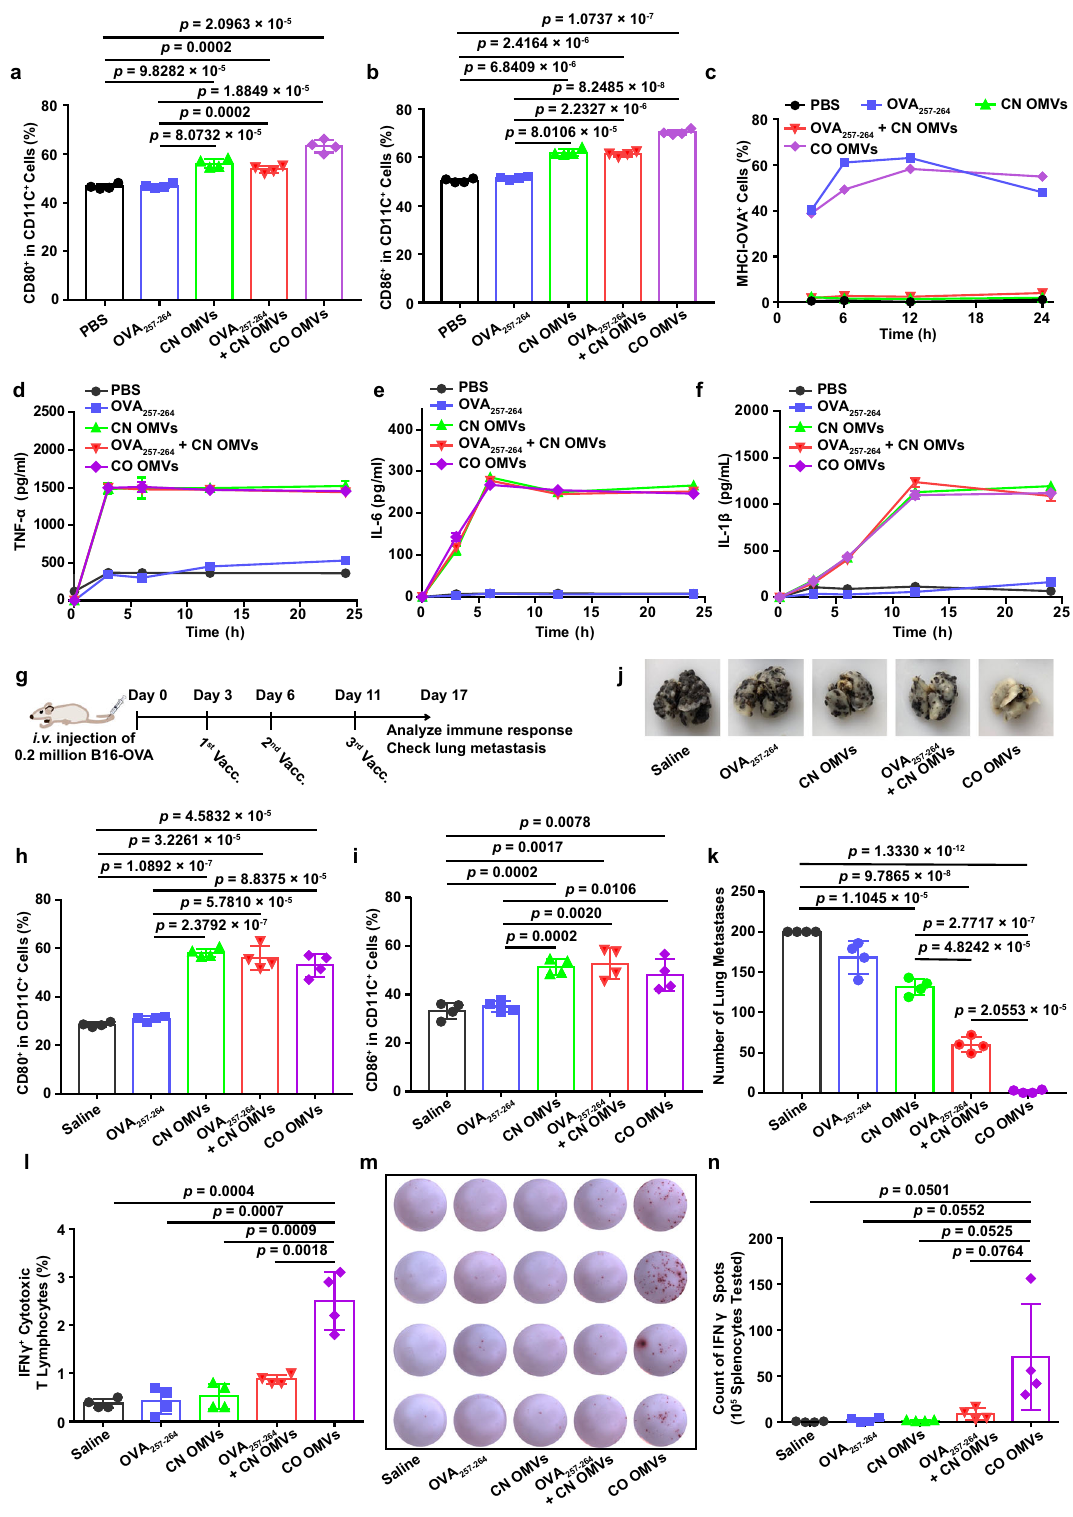
immunized with CO OMVs after exposing the cells to OVA 257 – 264 , compared with the other groups (Fig. 2m, n). We also analyzed the percentage of T-lymphocyte subpopulations in the inguinal lymph nodes (Supplementary Fig. 7a – e) and blood (Supplementary Fig. 8a – e) from the immunized mice. Immuniza- tion with OVA 257 – 264 + CN OMVs or CO OMVs signi fi cantly increased the numbers of CD3 + , CD3 + CD8 + , and CD3 + CD4 + T